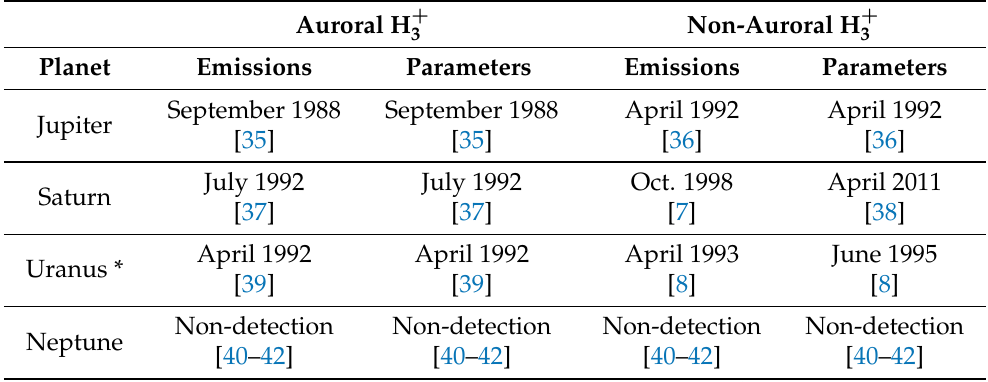
Table 1. Dates H + was first investigated in the upper atmospheres of giant 3